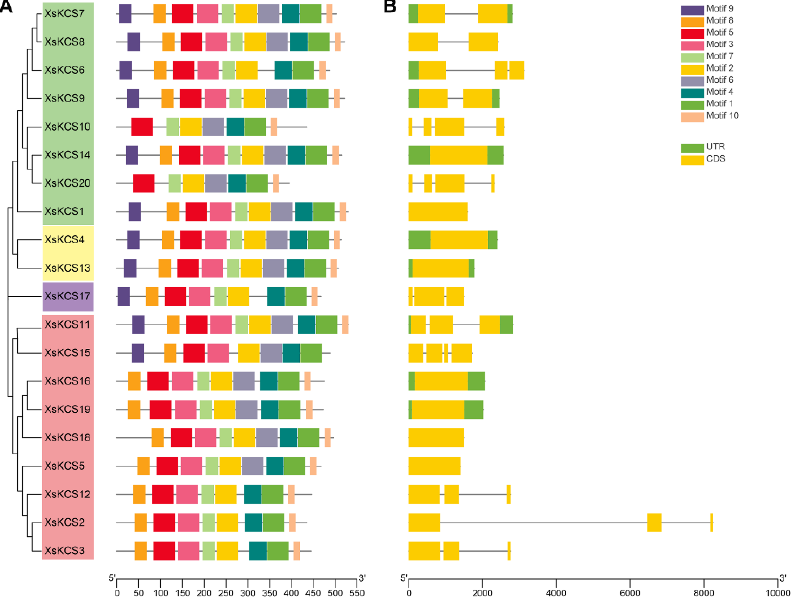
Figure 2. Conserved motifs and exon/intron structure analysis. ( A ) The conserved motifs of XsKCS proteins. Black lines indicate the non-conserved sequences. Different colored boxes indicated the putative motifs. Each motif size can be estimated by the scale located at the bottom. ( B ) Exon/intron structure analysis of XsKCS genes. The black line refers to the introns. The sizes of exons or introns can be estimated by the scale at the bottom.